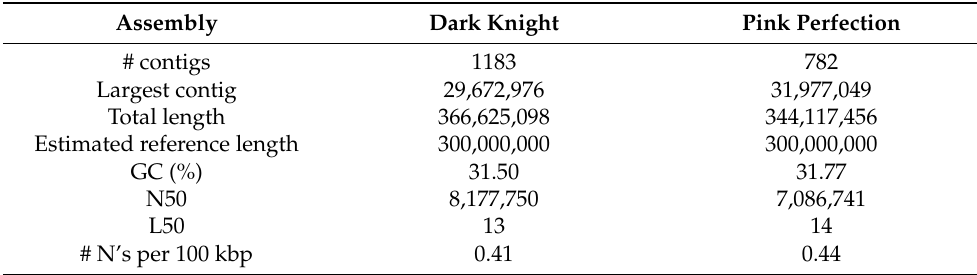
Table 3. Genome contiguity assessment based on statistics generated by using